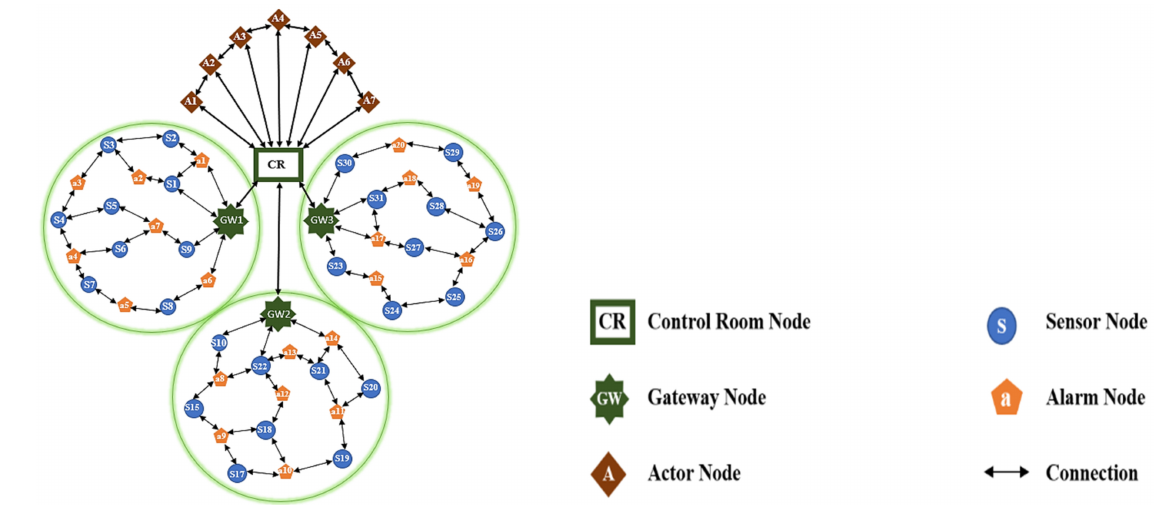
Figure 3. Graph-based